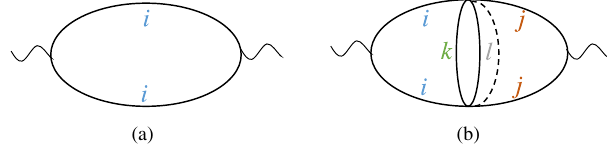
FIG. 3. Current-current correlation function for evaluating the conductivity in the one-band model. The wiggly line denotes the insertion of the current operator. The solid lines represent the fully dressed propagators. (a) Feynman diagram without vertex correc- tions. (b) The lowest-order vertex correction diagram, which is subleading in the high-temperature (LICM) regime. The dashed line represents a U 2 contraction, as c